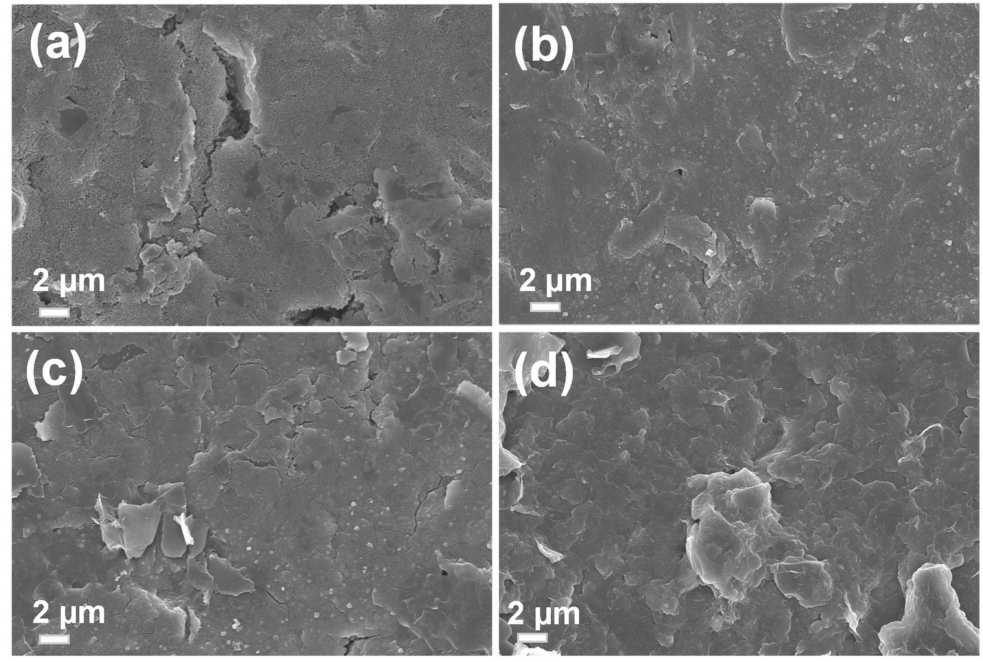
Figure 1. FE-SEM images of ( a ) bare SPCE; ( b ) PB/SPCE; ( c ) P-rGO/PB/SPCE; ( d ) GluOx- ASTENs/PB/SPCE; scale bar: 2 µ